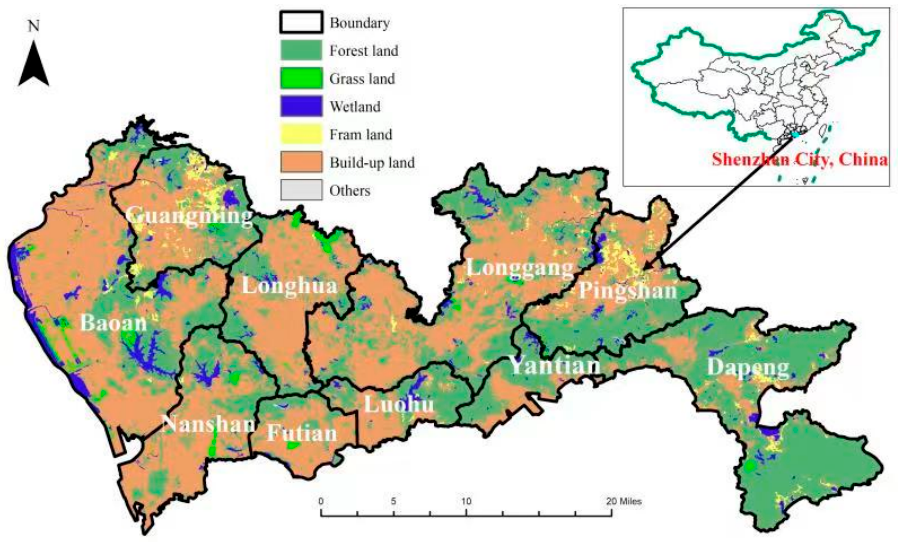
Figure 1. The location of Shenzhen City and its constituent administrative districts with the land use pattern by 2020. Table 1. The socioeconomic and geomorphic characteristics of the administrative districts within Shenzhen City during 2012–2020.